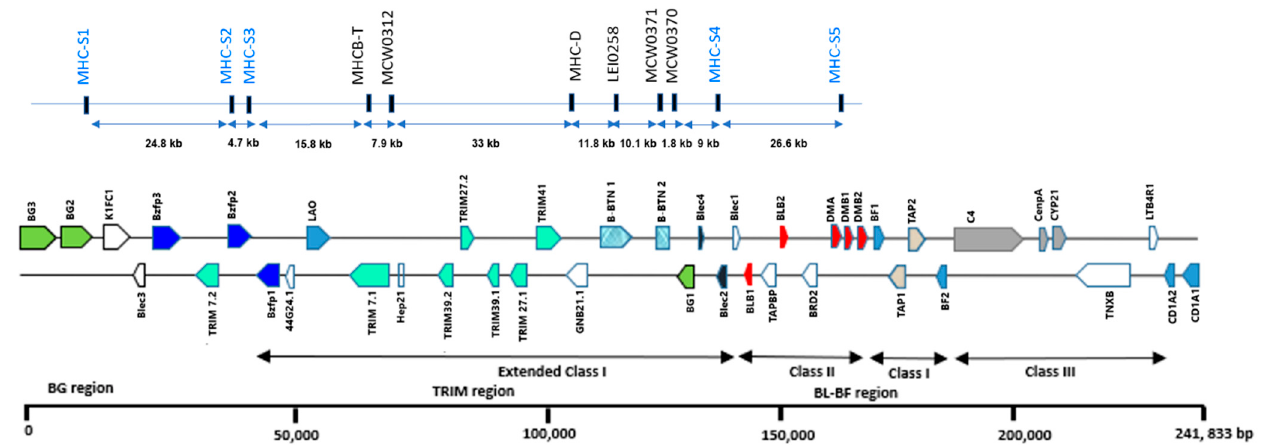
Figure 1. A graphical representation of microsatellite markers identified in chicken major histocompatibility complex (MHC)- B region. The loci in blue colour letters are novel microsatellite (MS) markers identified in this study (Set 1) whereas the markers in black colour letters are reported in the literature (Set 2). Physical positions and distance between the markers (not in the exact scale) are based on the sequence of GenBank accession number: NC_006103.5.